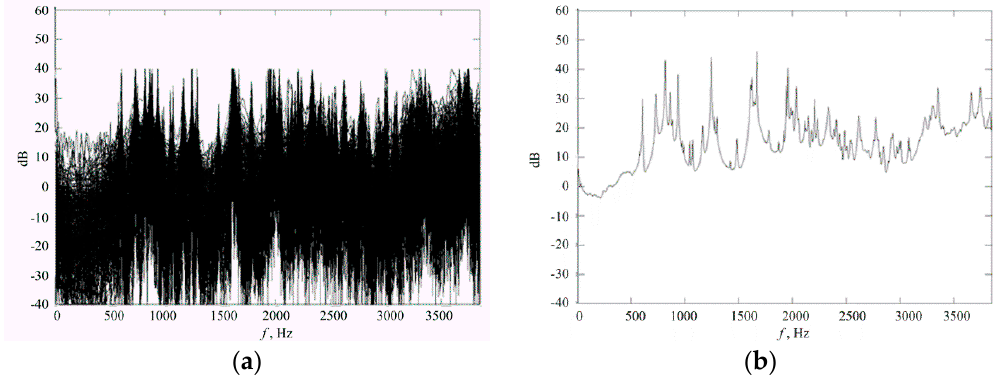
Figure 4. The frequency response functions: ( a ) transfer functions; ( b ) average transfer function.